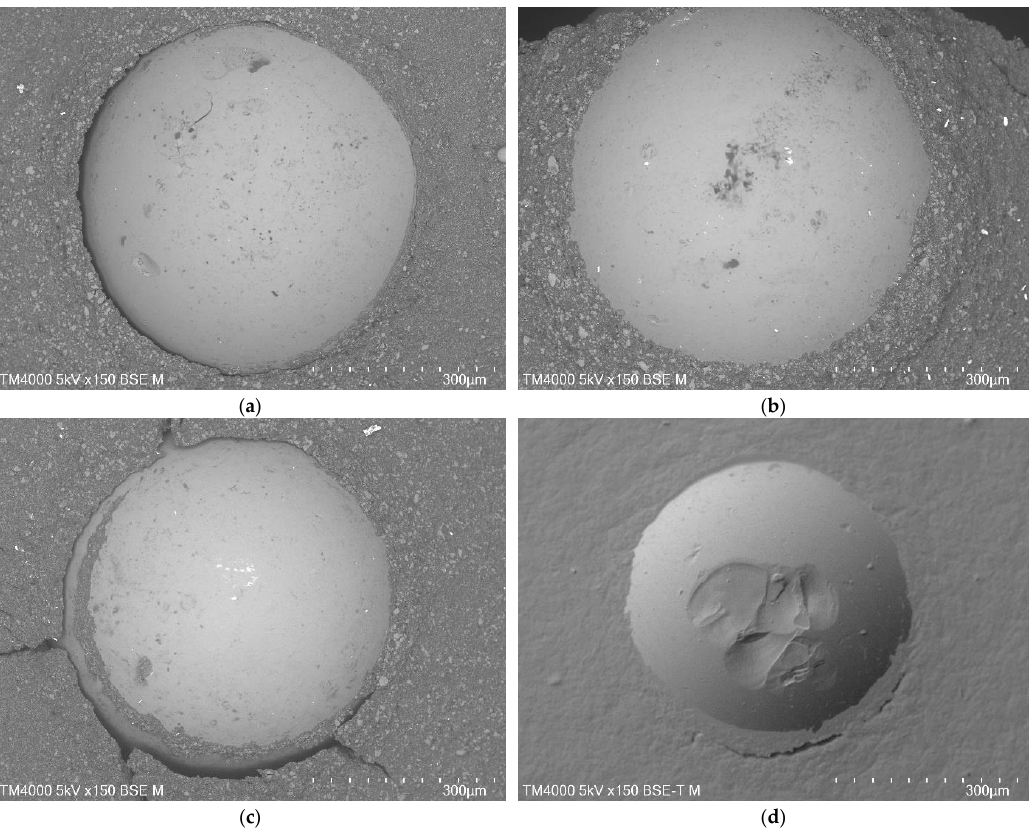
Figure 8. SEM images (magnification 150 × ) of GB after exposure to 168 drum rotations with corundum: ( a ) standard (sample SF ), ( b ) large (sample ML ), ( c ) premium (sample SP ), ( d ) high index (sample HI ).